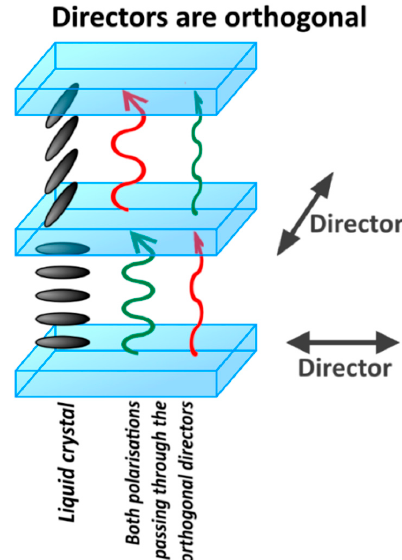
Figure 16. Polarization independence is achieved by aligning directors orthogonal to one another in each LC chamber. However, the optical path length (OPL) must be the same for both chambers to keep the phase of polarizations passing through both n e and n o orientations in phase with one another.